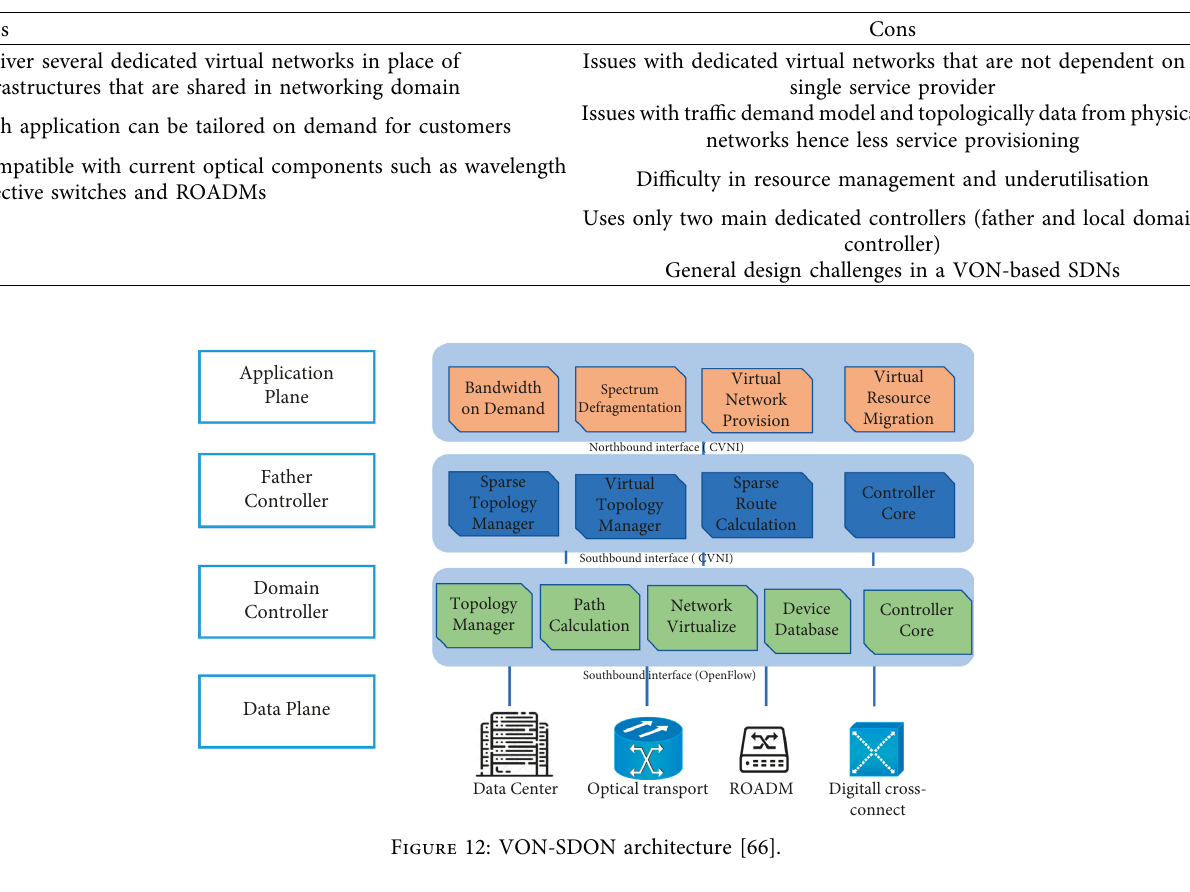
Table 6: Pros and cons of standard virtualised architectures.